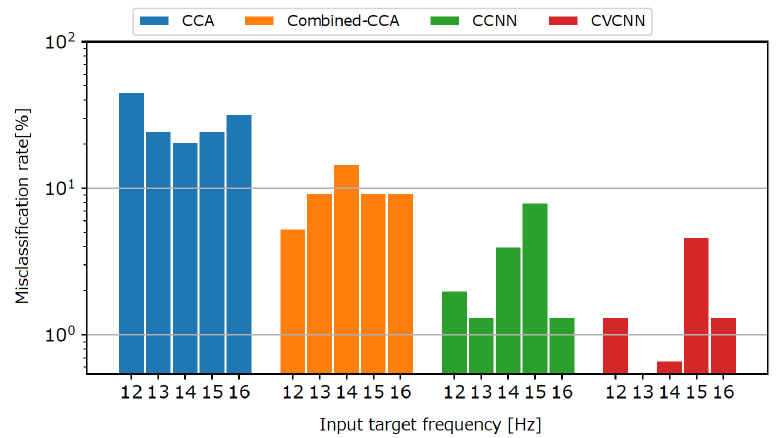
Figure 5. Misclassification rate for another target of harmonic